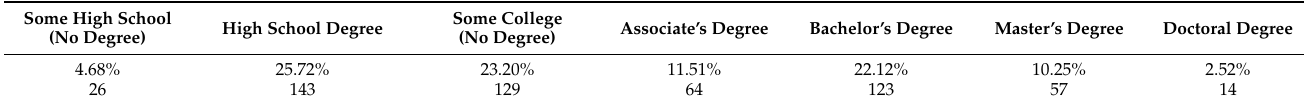
Table 3. Respondents’ education distribution